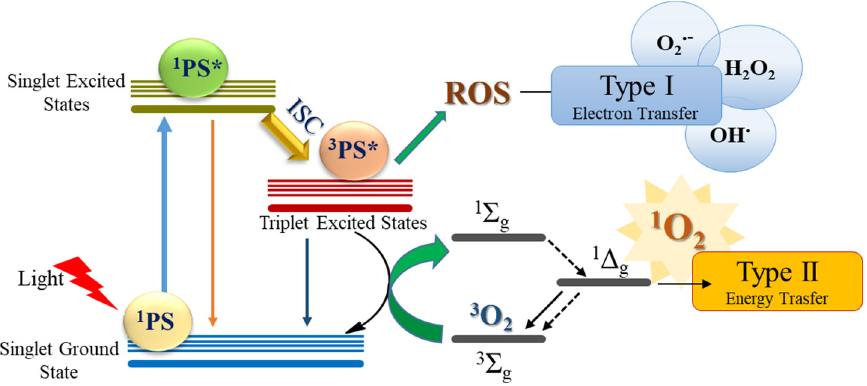
Figure 1. Schematic Jablonski’s diagram showing Type I and Type II photoreactions. In the picture, * stands for excited species.